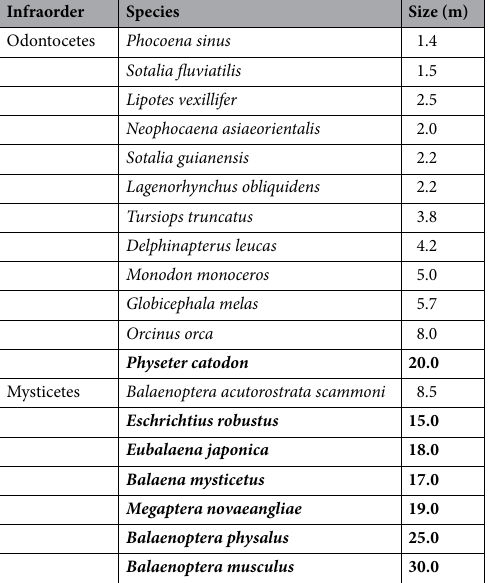
Table 2. Average size in meters of all cetacean species included in this study. Significant values are in [bold]. True gigantism in cetaceans was defined as body length above 10 m. Physeter catodon , Balaena mysticetus , Eschrichtius robustus , Megaptera novaeangliae , Eubalaena japonica , Balaenoptera physalus , and Balaenoptera musculus are classified as giants. Information from Encyclopedia of Marine